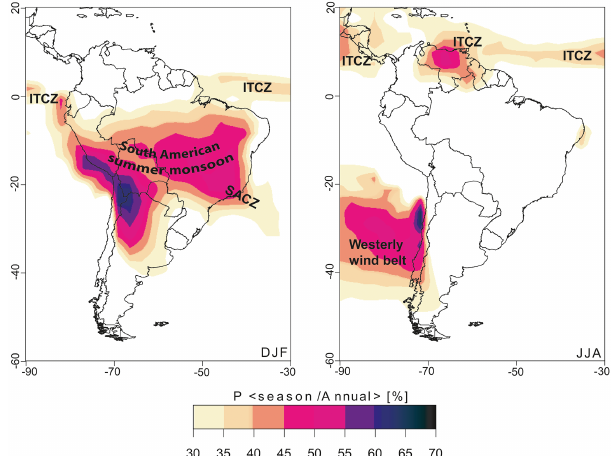
Figure 1. Map showing the relative precipitation amount over South America during the key seasons DJF (austral summer and mature monsoon phase) and JJA (dry season over much of tropical South America), highlighting the Intertropical Convergence Zone (ITCZ), South American summer monsoon, South Atlantic conver- gence zone (SACZ), and extratropical westerlies. Figure based on CPC Merged Analysis Precipitation (CMAP) data. Adapted from Vuille et al.